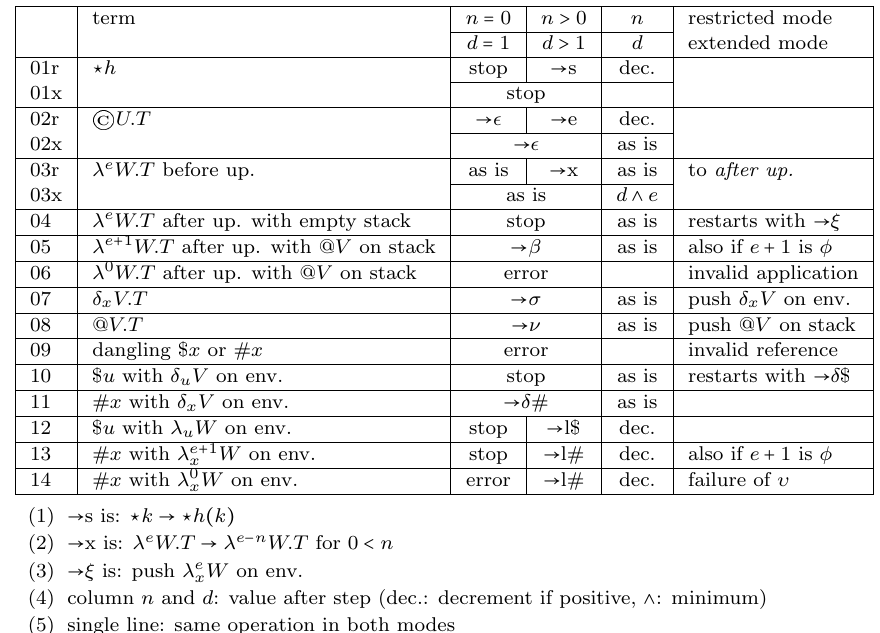
Fig. 9. Operational semantics of the